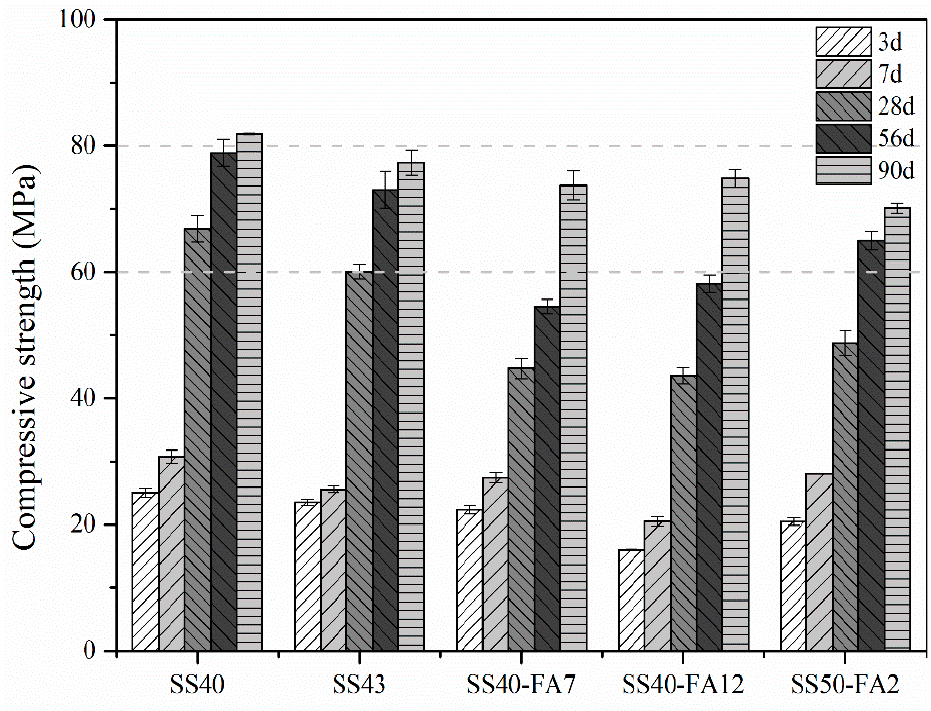
Figure 6. Compressive strength of SS-based composite cementitious materials at di ff erent ages.